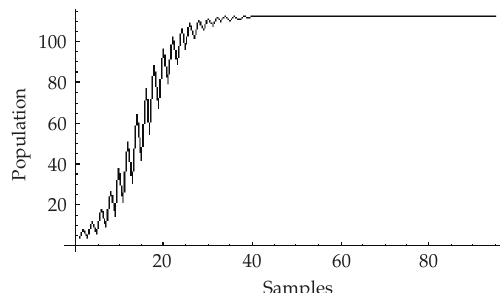
Figure 1: μ (cid:8) 2 , K (cid:8) 200 , d (cid:8) 0 , p (cid:8) 0 . 01 , α (cid:8) 0 . 002 , and γ (cid:8) 0 . 8.